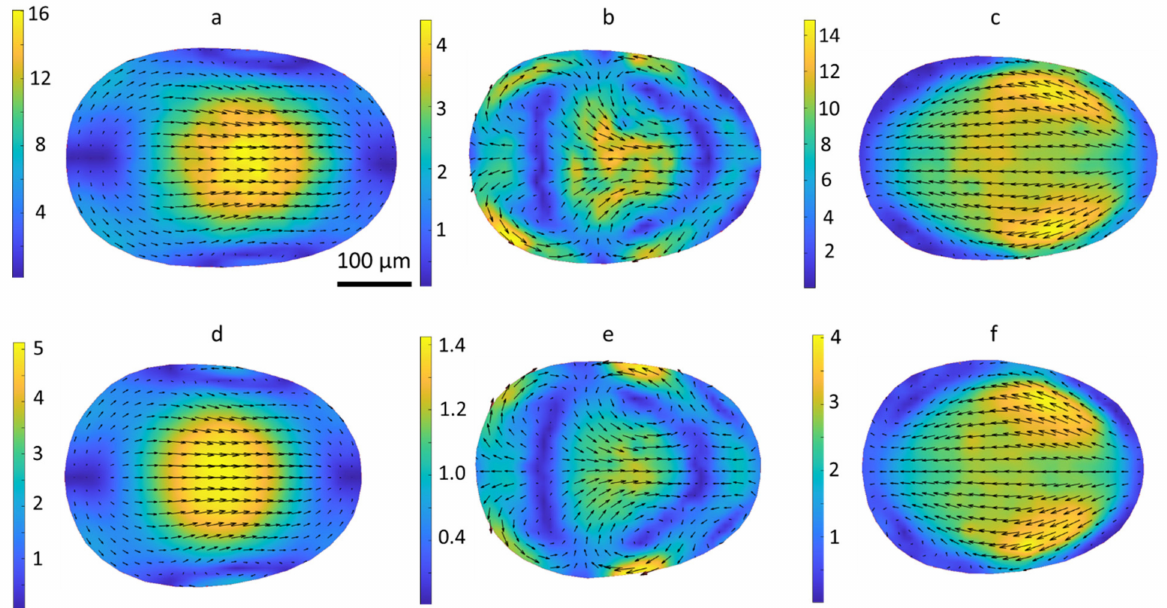
Figure 4. Flow fields inside a drop in the co-ordinate frame of the drop: top panel, surfactant-free, total flow rate Q = 96 µ L/min, Ca = 0.040, drop length L = 430 ± 20 µ m, drop velocity V d = 34.1 ± 0.8 mm/s, ( a )—middle plane, ( b )—60 µ m from the middle plane, ( c )—80 µ m; bottom panel, C 10 TAB, 1.5 cmc, Q = 32 µ L/min, Ca = 0.037, drop length L = 397 ± 6 µ m, drop velocity V d = 11.1 ± 0.3 mm/s, ( d )—middle plane, ( e )—60 µ m from the middle plane, ( f )—80 µ m. The velocity on color scales is given in mm/s.